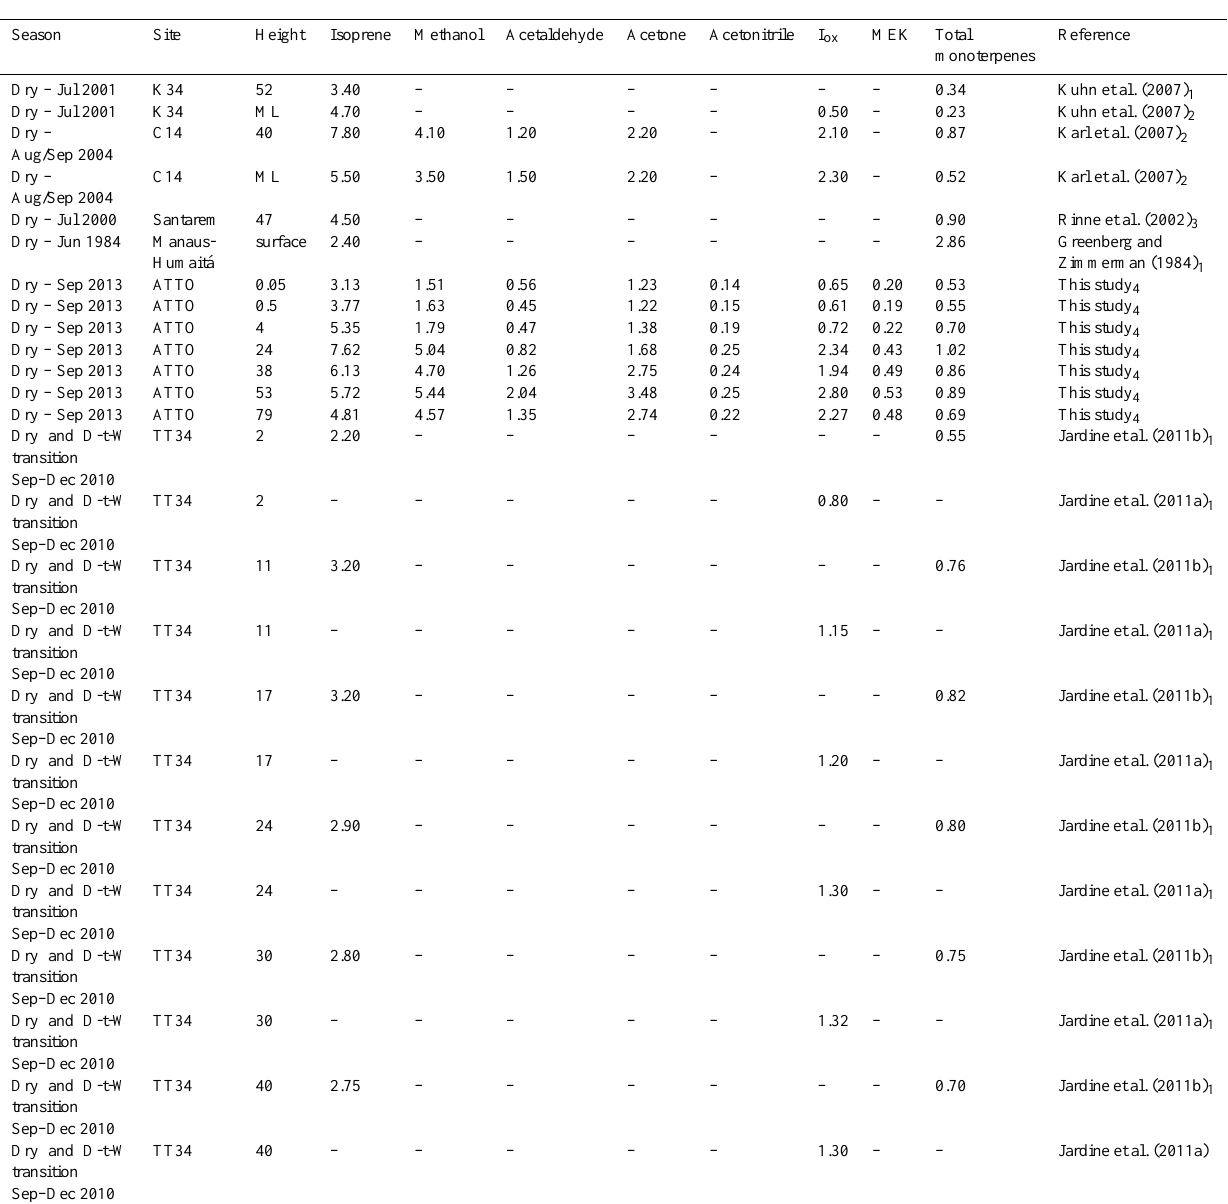
Table 2. Mixing ratios of isoprene, methanol, acetaldehyde, acetone, acetonitrile, MEK, isoprene oxidation products (I ox ) and total monoter- penes measured at different Amazonian forest sites. In the second column different sites can be found: Duke reserve is a scientific research site 25km north-east of Manaus (2 ◦ 55 (cid:48) S, 59 ◦ 59 (cid:48) W); Peru (4 ◦ 35 (cid:48) 15 (cid:48)(cid:48) S 77 ◦ 28 (cid:48) 00 (cid:48)(cid:48) W); Balbina 100km north-east of Manaus (1 ◦ 59 (cid:48) S, 59.12 (cid:48) W); C14 a tower in the Reserva Biologica de Cuieiras, 50km NW of Manaus (2 ◦ 28 (cid:48) S, 60 ◦ 09 (cid:48) W); Surinam (2–5 ◦ N, 54–57 ◦